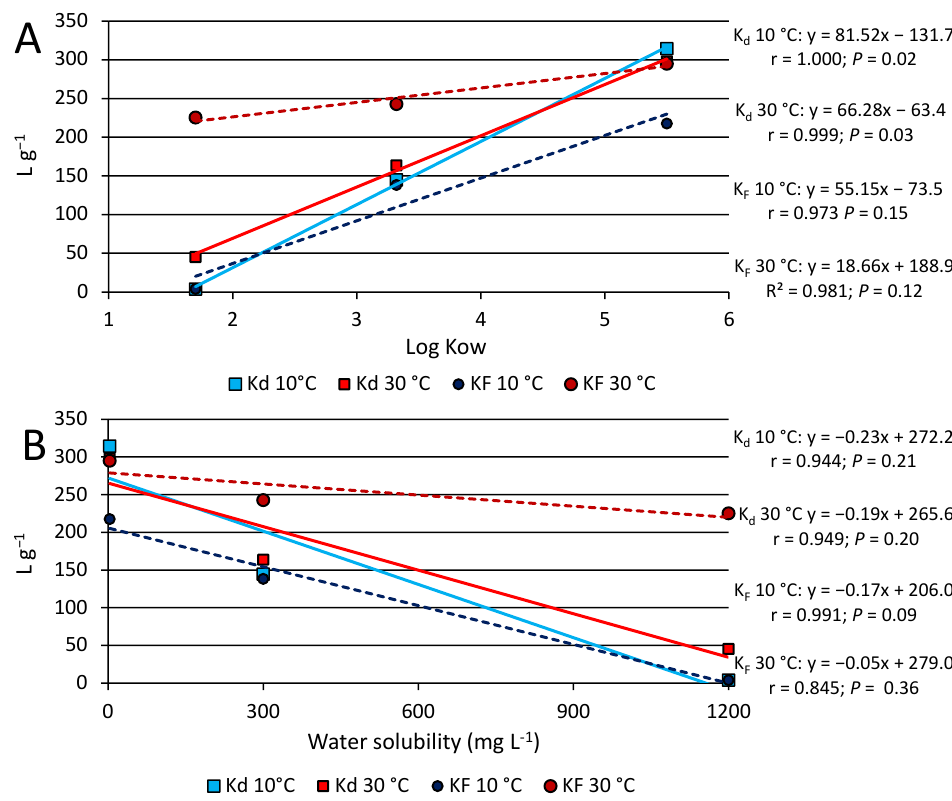
Figure 8. Plots of the correlations between the distribution coefficient, K d , and the Freundlich constant, K F , and the corresponding log Kow ( A ) and water solubility ( B ) of the compounds.